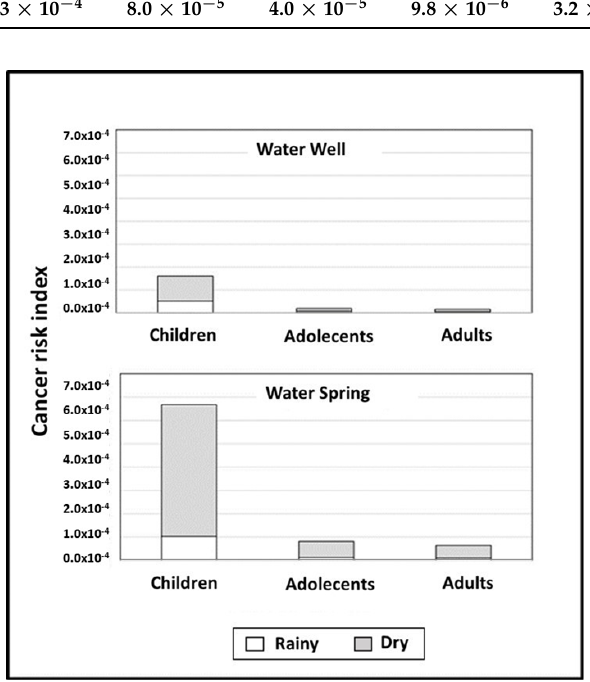
Figure 3. Total cancer risk index due to the intake of spring water metals and wells water, for the subpopulation of children, adolescents and adults of E. Portes Gil.